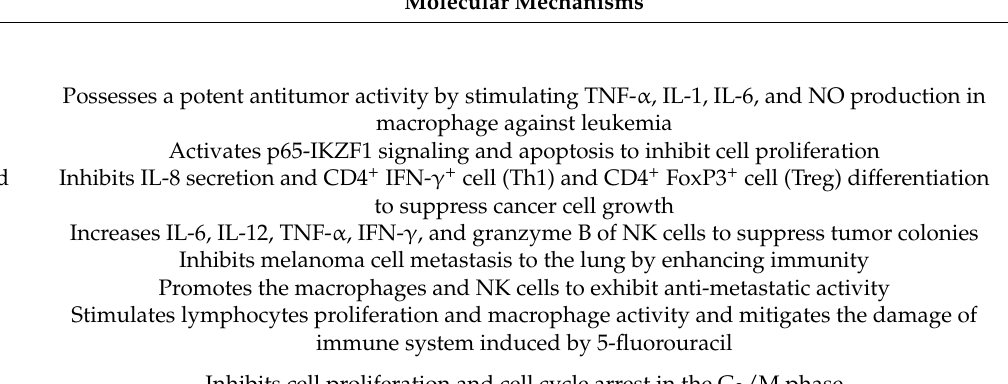
Table 5. Activities and molecular mechanisms of polysaccharides from ginseng, American ginseng, and